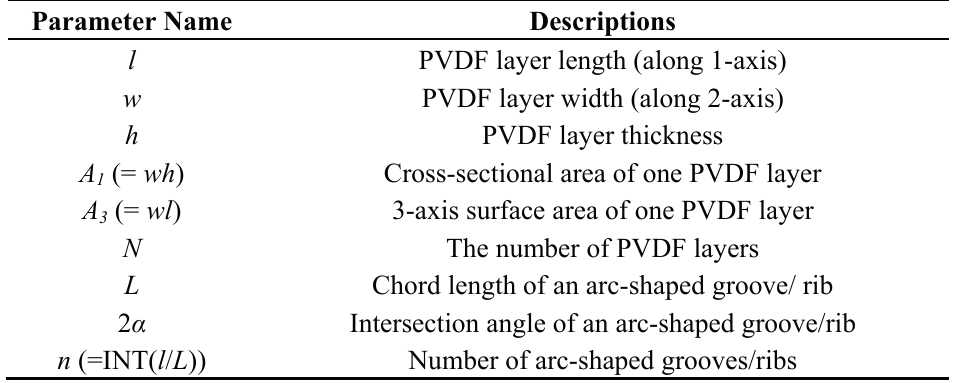
Table 1. Design parameters.